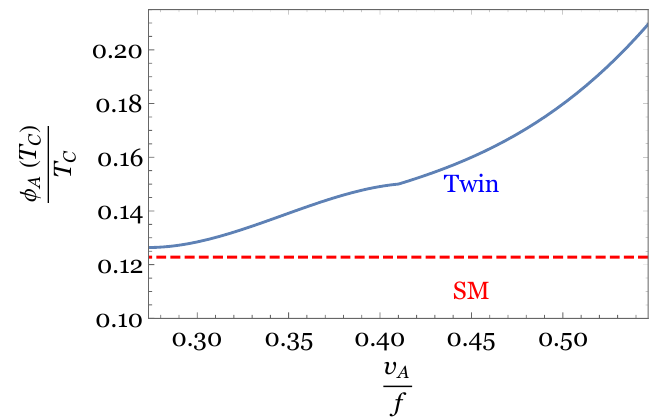
Figure 3 . The ratio (cid:30) ( T ) =T for each U(4) symmetry breaking scale f . The blue curve repre- A C C sents (cid:30) ( T ) =T evaluated by use of eq. (3.20). The dashed red line represents the same ratio but A C C with only the Standard Model contributions being taken into